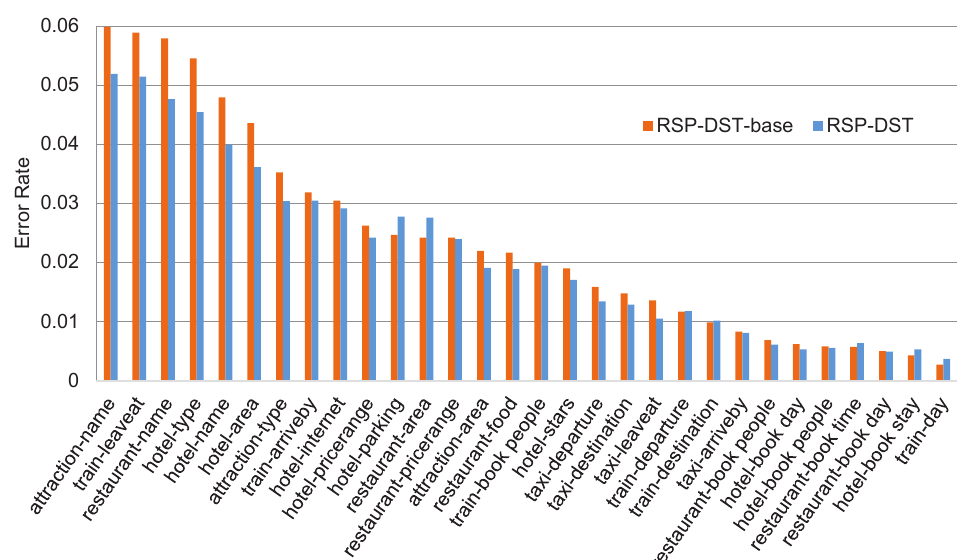
Figure 9. The error rate of every slot on the test set of MultiWOZ 2.1.